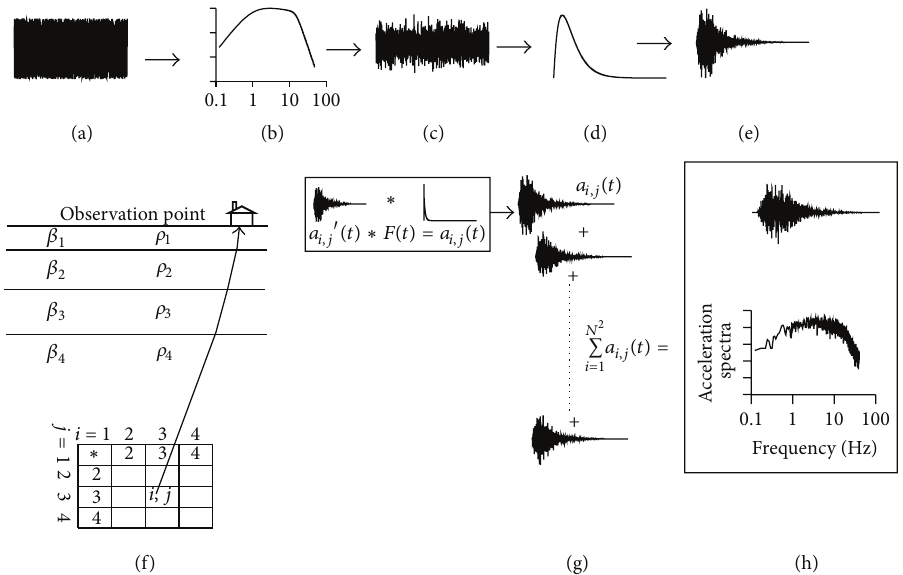
Figure 1: Method of simulation of strong ground motion showing (a) white Gaussian noise, (b) filter representing actual earthquake process, (c) filtered white noise, (d) envelope of accelerogram released by i , j element within the rupture plane shown in (f), (e) multiplication of the envelope with filtered white noise, (f) rupture plane divided into 4 × 4 elements in the layered earth with i , j , element releasing record which is convolved with the correction factor F(t), (g) summation of all accelerograms from various elements according to their arrival time at the observation point, and (h) the simulated acceleration record and its acceleration spectrum. Figure modified after Joshi [10].